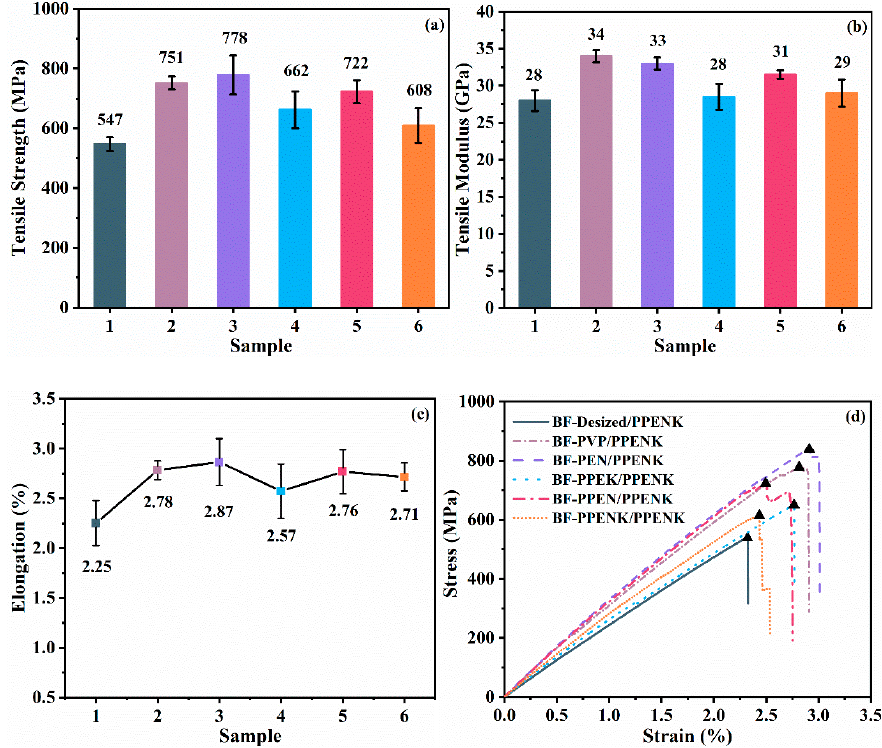
Figure 3. Tensile properties of the 1: BF—Desized/PPENK, 2: BF-PVP/PPENK, 3: BF-PEN/PPENK, 4: BF-PPEK/PPENK, 5: BF-PPEN/PPENK and 6: BF-PPENK/PPENK composites; ( a ) strength, ( b ) modulus, ( c ) breaking strain and ( d ) stress–strain curves.